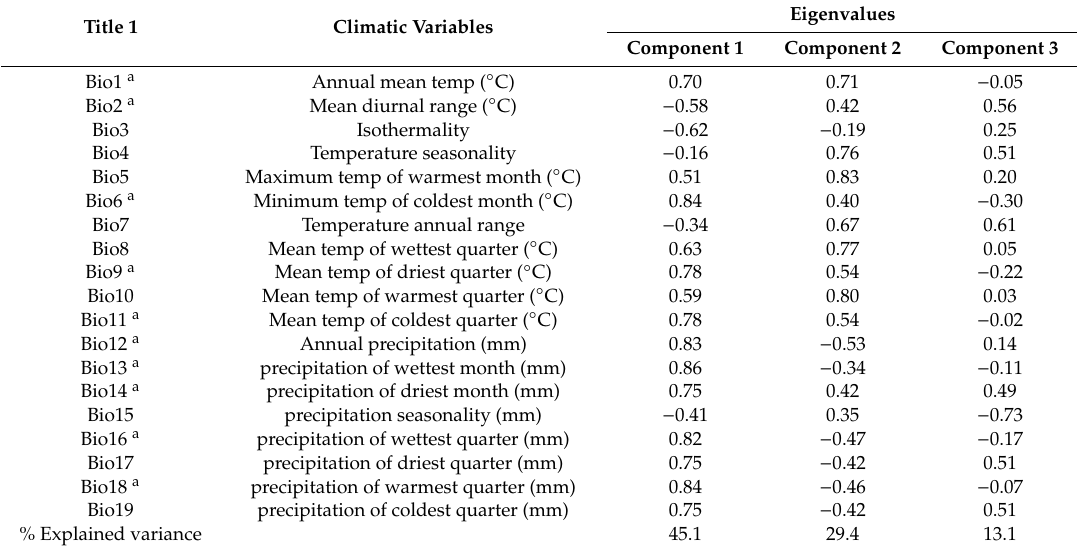
Table 3. Principal component analysis (PCA) of Bioclim climatic variables in relation to the occurrence of D.